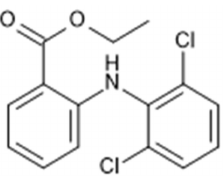
Figure 19 Molecule to be fragmented